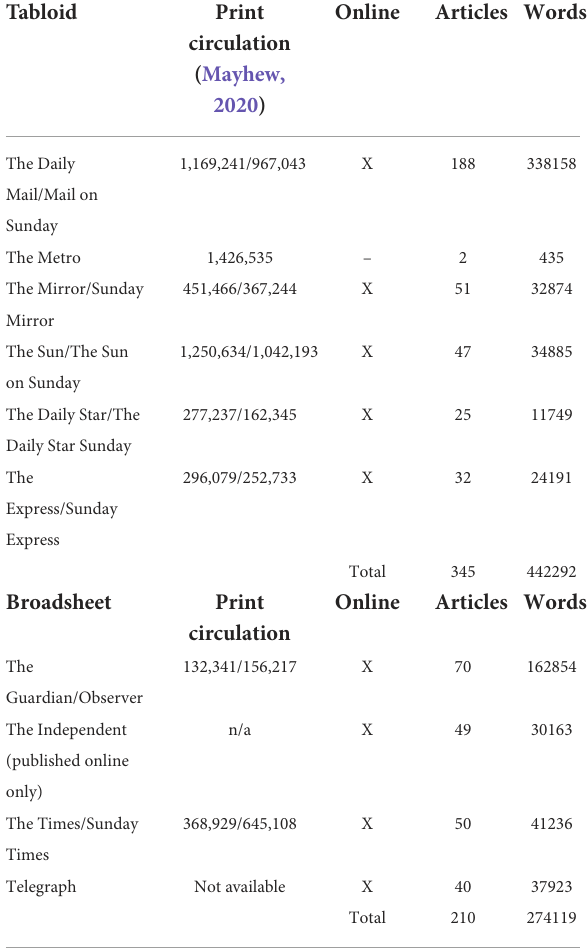
TABLE 1 Overview of the corpus composition.